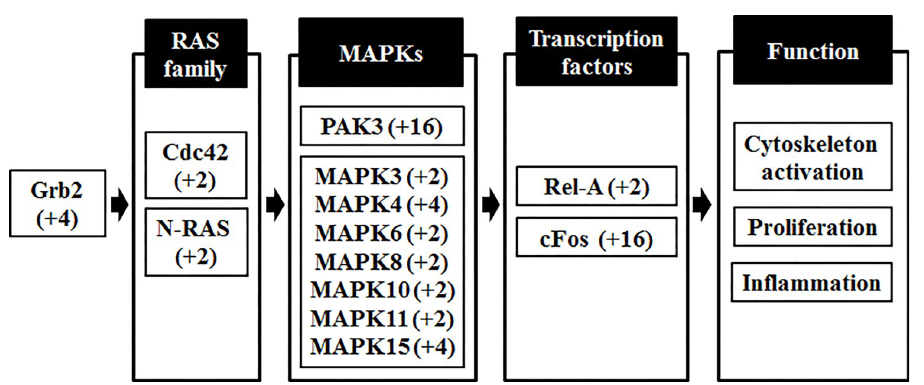
Fig 3. Analysis of protein kinase signaling pathways in butyrate-treated LoVo cells. The cDNA converted from total mRNA was applied to a TaqMan array 96-well fast plate, and comparative Ct method was used to calculate relative gene expression levels. The delta Ct value was determined by subtracting the delta Ct of the control sample from the individual Ct of the butyrate-treated samples. Significant changes in butyrate-induced gene expression were screened by filtering genes more than 2-fold increase of transcript compared to the control group. A fold change of the gene expression is shown in the parenthesis. MAPK, mitogen-activated protein kinase.